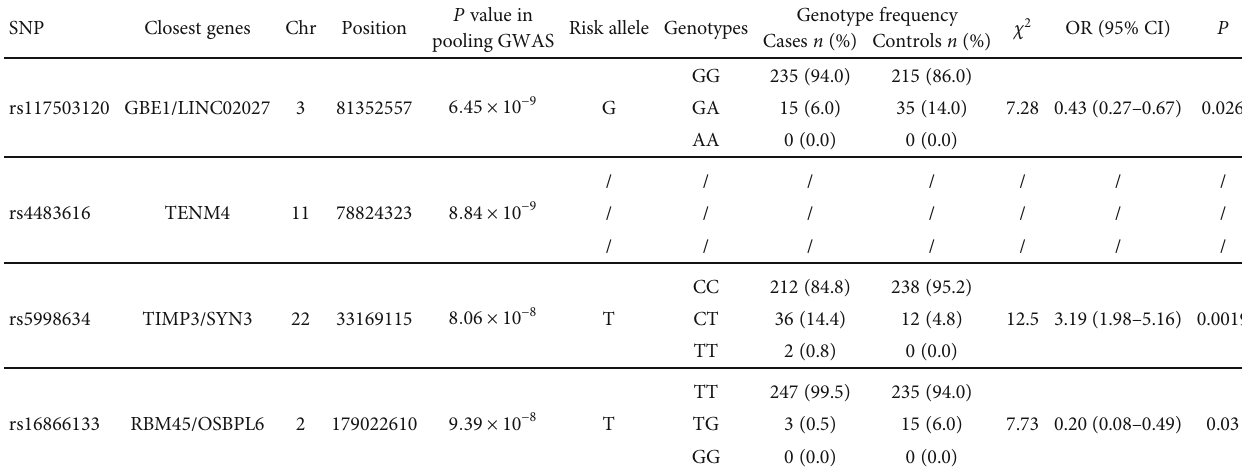
Table 2: The genotype frequency of four signi fi cant loci between ITP patients and controls.